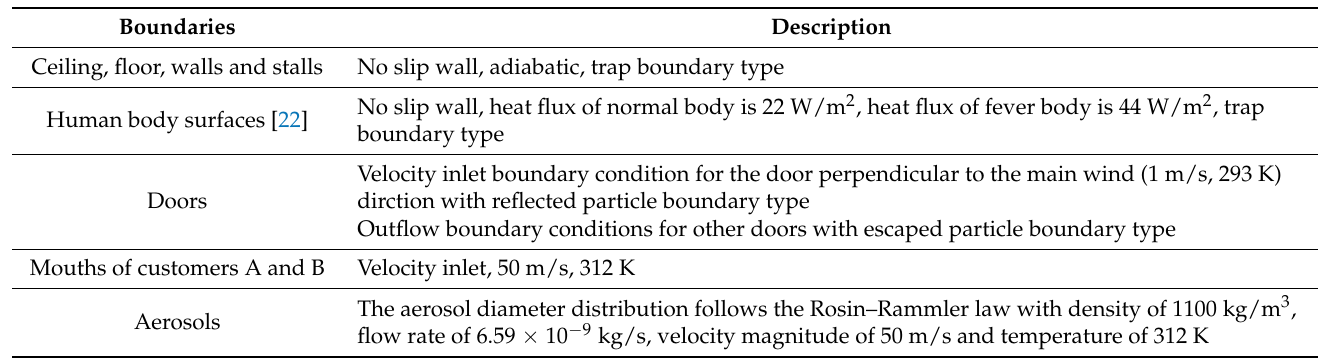
Table 2. Boundary conditions.